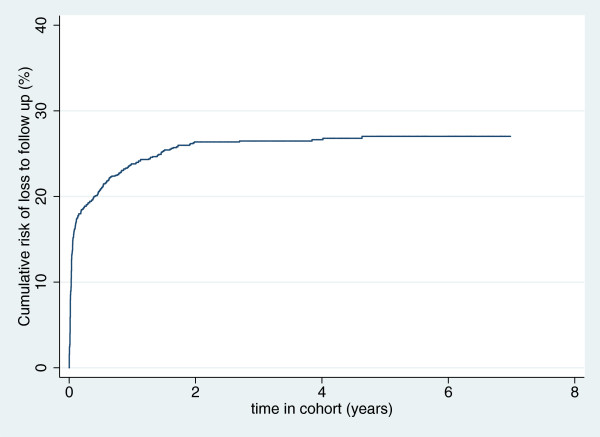
Kaplan-Meier curve of cumulative probability of loss to follow-up.